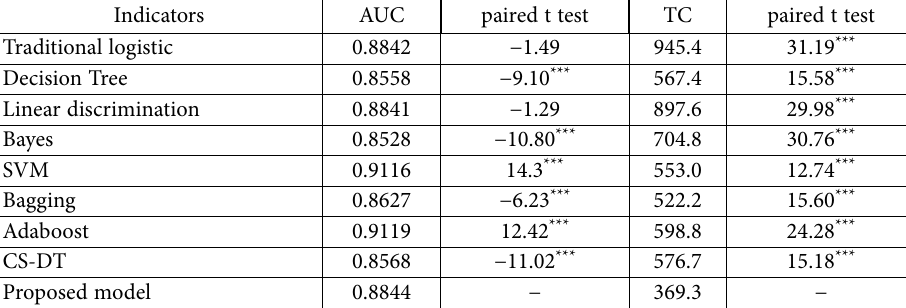
Table 6. Significance test for the AUC and